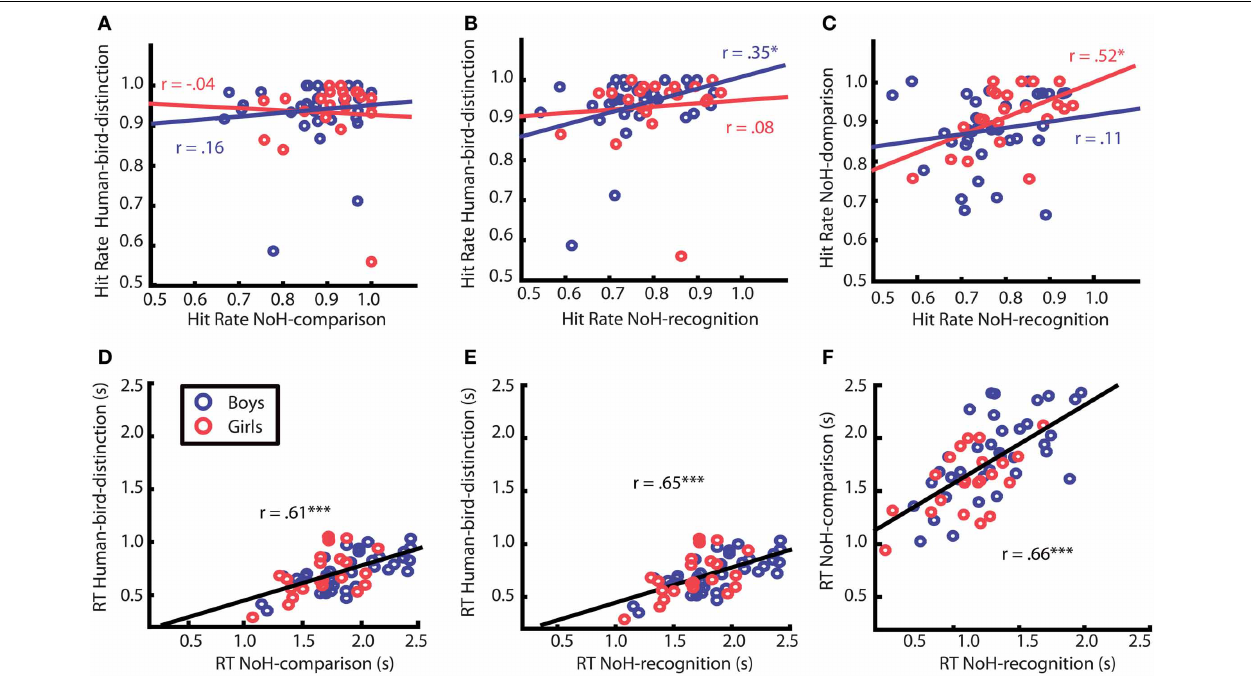
FIGURE 6 | Correlation of hit rates (top) and RTs (bottom) between different paradigms. Each data point corresponds to the mean values for one child. Red circles represent girls, blue ones boys. Correlation patterns differed between girls and boys only for hit rates (see upper row A , B and C ), but did not for response times (RTs, see bottom row, D , E and F ). Red and